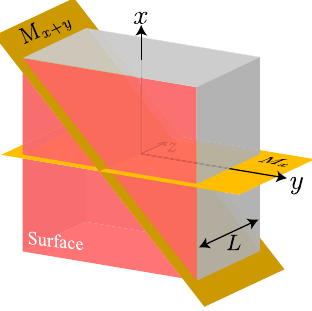
FIG. 7. System geometry of the slab